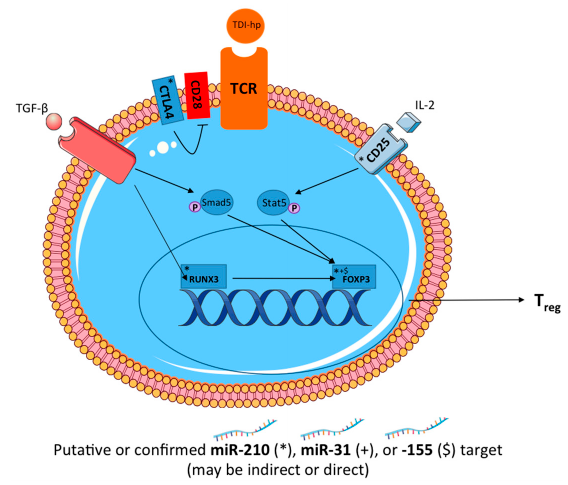
Figure 8. Proposed model of selected miRNA action on the regulatory T cell pathway. Integral components of the T reg activation pathway are highlighted alongside putative direct targets or key players indirectly impacted by miRNA-210 (indicated by *), -31 (indicated by +), and -155 (indicated by $). Legend: CD28, Cluster of differentiation 28; CD25, IL-2 receptor alpha (in complex with IL-2R β and γ c); CTLA4, Cytotoxic T-lymphocyte associated protein 4; Foxp3, Forkhead box P3; P, Phosphate group; Runx3, Runt related transcription factor 3; Smad5, Mothers against decapentaplegic homolog 5; Stat5, Signal transducer and activator of transcription 5, TCR, T cell receptor; TDI-hp, Toluene diisocyanate haptenated complex; TGF- β 1, Transforming growth factor beta